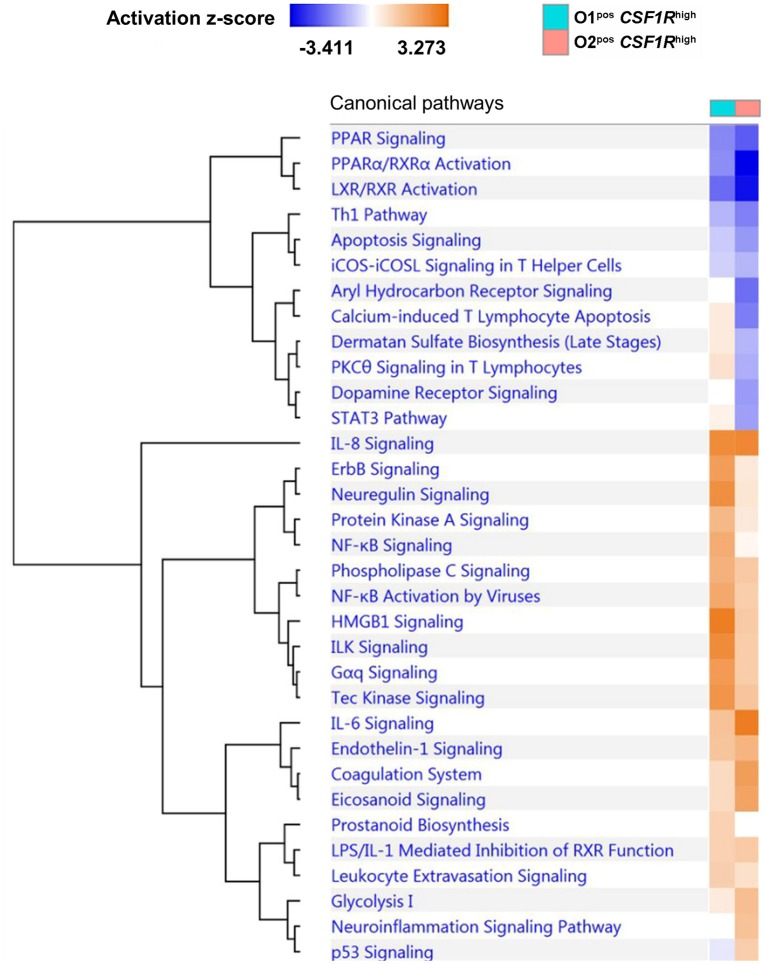
Comparative pathway analysis of APEC O1-GFP vs. APEC O2-GFP infected CSF1R-tghigh cells based on the log fold-changes of genes differentially expressed compared to CSF1R-tghigh cells from PBS control samples. Coloring shows enrichment of pathways in APEC-bearing samples compared to PBS controls (blue = pathway suppressed, orange = pathway activated). A total of 1374 (O1) and 1405 (O2) genes were included in the analysis.